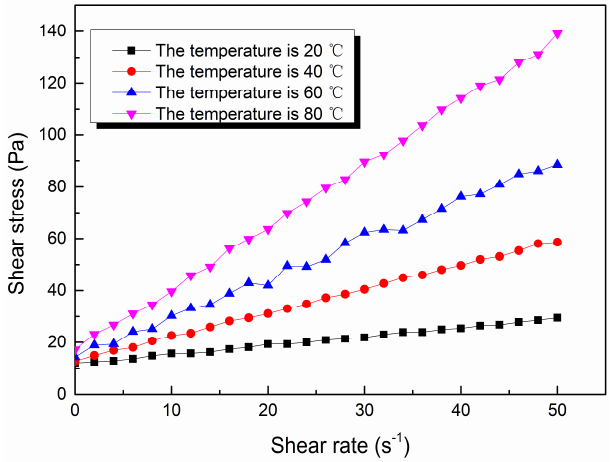
Figure 14. The rheological curve of the cement-sodium silicate slurry at different temperatures.